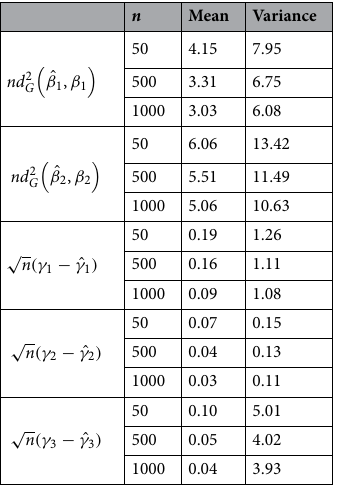
Table 2. The mean and variance of nd 2 G